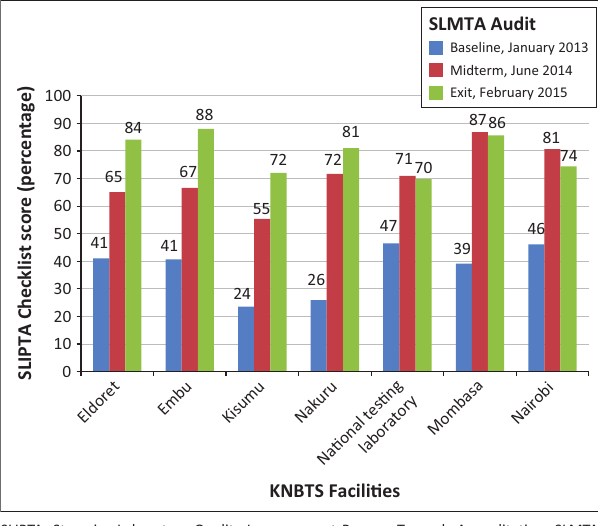
FIGURE 2: Average SLIPTA checklist scores at the SLMTA baseline, midterm and exit audits for Kenya National Blood Transfusion Service facilities. Scores were calculated from the SLIPTA checklist based on points earned for each quality system essential out of a possible total of 258. SLMTA audit stars are awarded based on the percentage of total points earned according to the following rating system: zero stars (< 55 % ), one star (55 % – 64 % ), two stars (65 % – 74 % ), three stars (75 % – 84 % ), four stars (85 % – 94 % ), and five stars (≥ 95 % ).